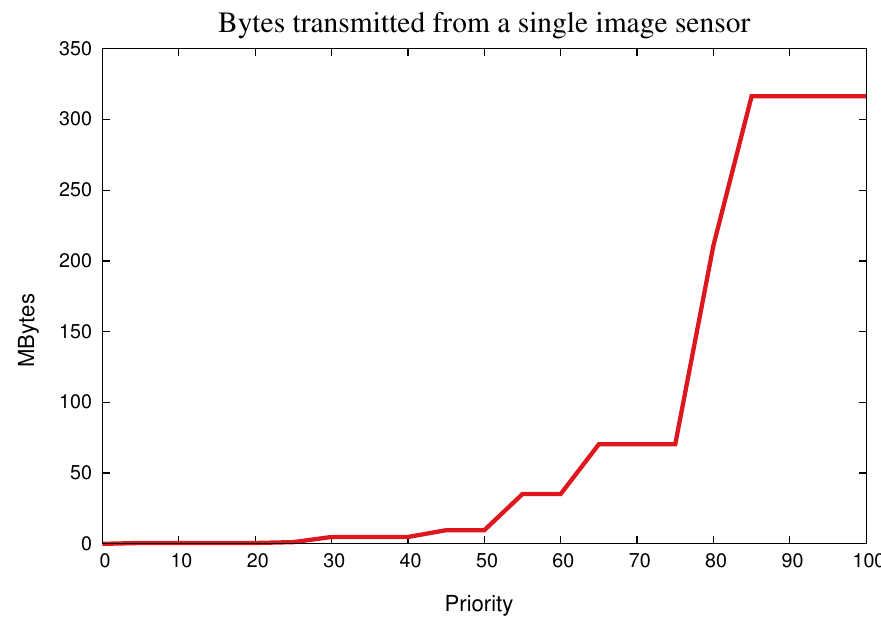
Figure 11. Transmissions from a single image sensor according to the assigned